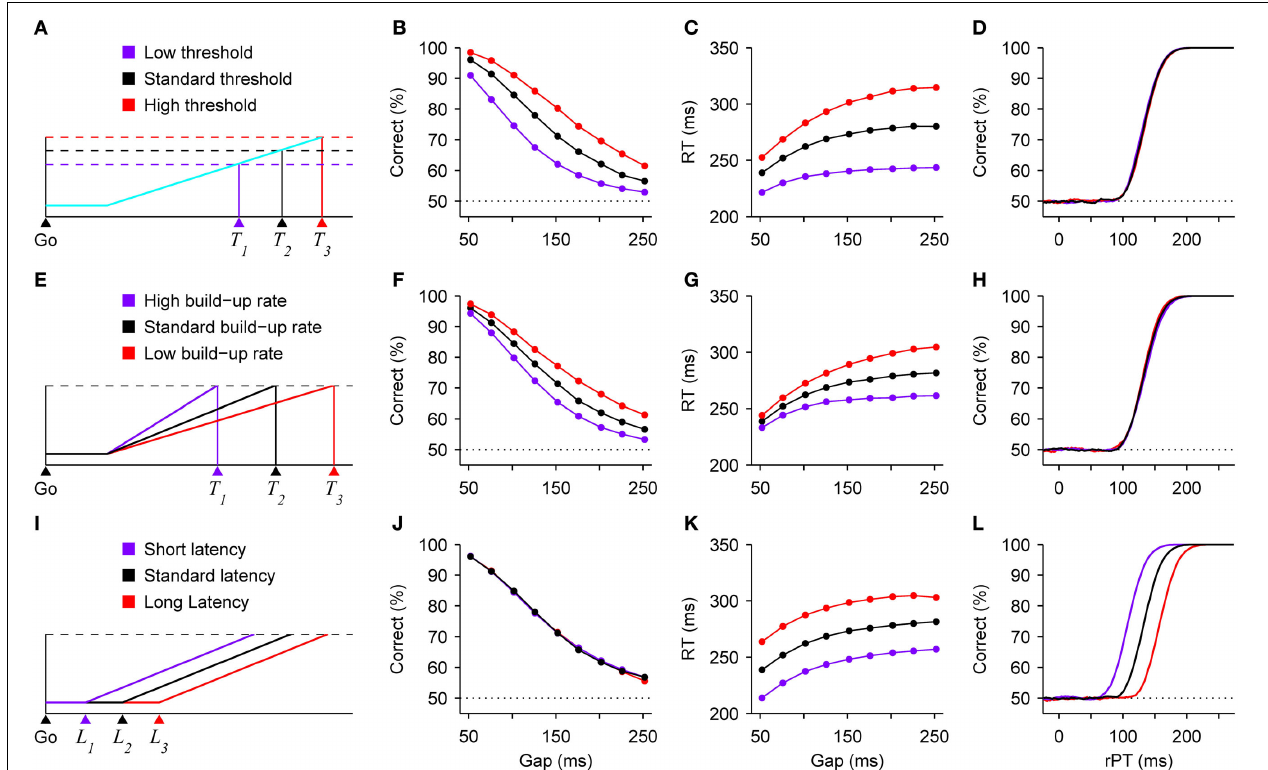
FIGURE 2 | Changes in speed and accuracy generated by three distinct mechanisms. All results are expectations based on model simulations of the compelled-saccade task. (A) Schematic of a developing oculomotor plan. A saccade is triggered shortly after motor-related activity (blue trace) reaches a threshold (dotted lines). The threshold-crossing time, and thus the RT, varies withthethresholdvalue. (B–D) Modelresults.Variationsinthresholdproducea standard speed-accuracy trade-off. As the threshold increases, both performance (B) andmeanRT (C) increase,butthetachometriccurve (D) does not change. (E) Schematic illustrating how threshold-crossing time varies with the build-up rate of the motor plan. (F–H) Model results. Variations in mean build-up rate also produce a trade-off. As the mean build-up rate decreases,